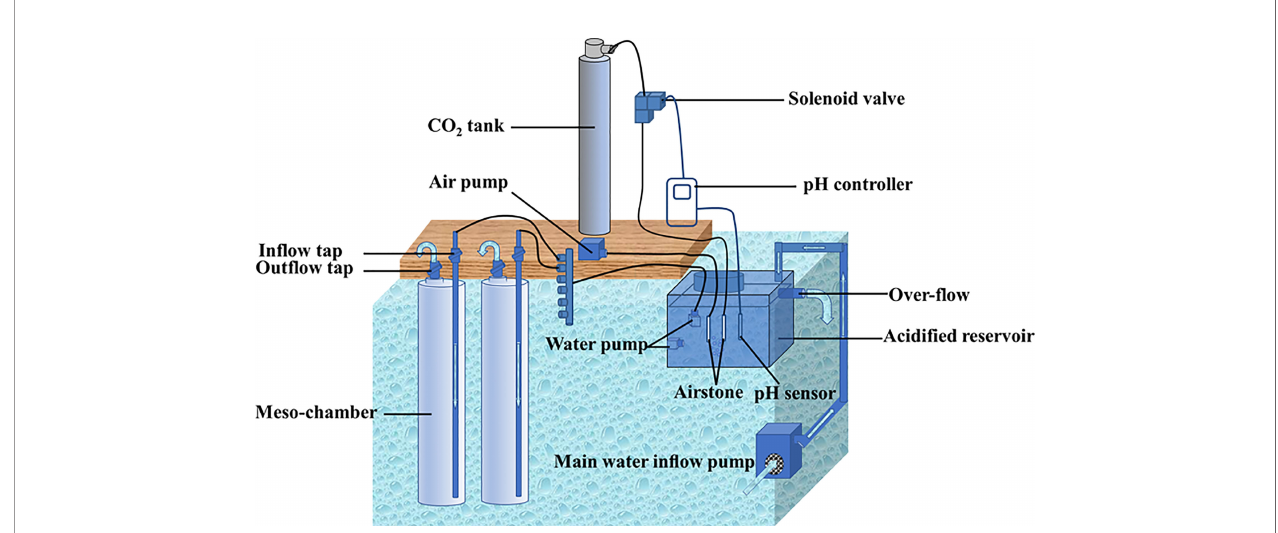
FIGURE 1 | Schematic diagram of the pH controlling and mesocosm